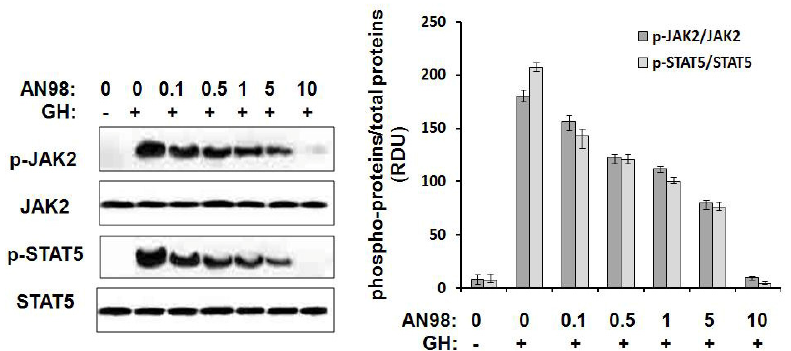
Figure 5. Inhibition of pGH-induced signalling by AN98 in porcine hepatocytes. Porcine hepatocytes were cultured in serum starvation media for 10 h. A constant amount of pGH (100 ng) was pre-incubated with different concentrations of AN98, then the mixtures were added to the plates for 25 min at 37°C. After incubation, cell extracts were harvested, and samples (30 μ g of protein per lane) were subjected to SDS–PAGE (10% gel) and transferred to a PVDF membrane. After blocking the membrane with 5% non-fat milk, the membrane was probed with phospho-JAK2 phospho-STAT5 antibodies according to the manufacturer’s protocols. The membranes were then washed and incubated with secondary antibody conjugated to HRP for 2 h. After three washes with PBST, protein bands were detected using the ECL system. The figures represent at least three independent experiments. pGH, porcine growth hormone; SDS– PAGE, sodium dodecyl sulfate-polyacrylamide gel electrophoresis; PVDF, polyvinylidene fluoride; JAK2, janus kinase 2; STAT5, signal transduction and activator of transcription; HRP, horseradish peroxidase; ECL, enhanced chemiluminescent; PBST, phosphate buffer solution with